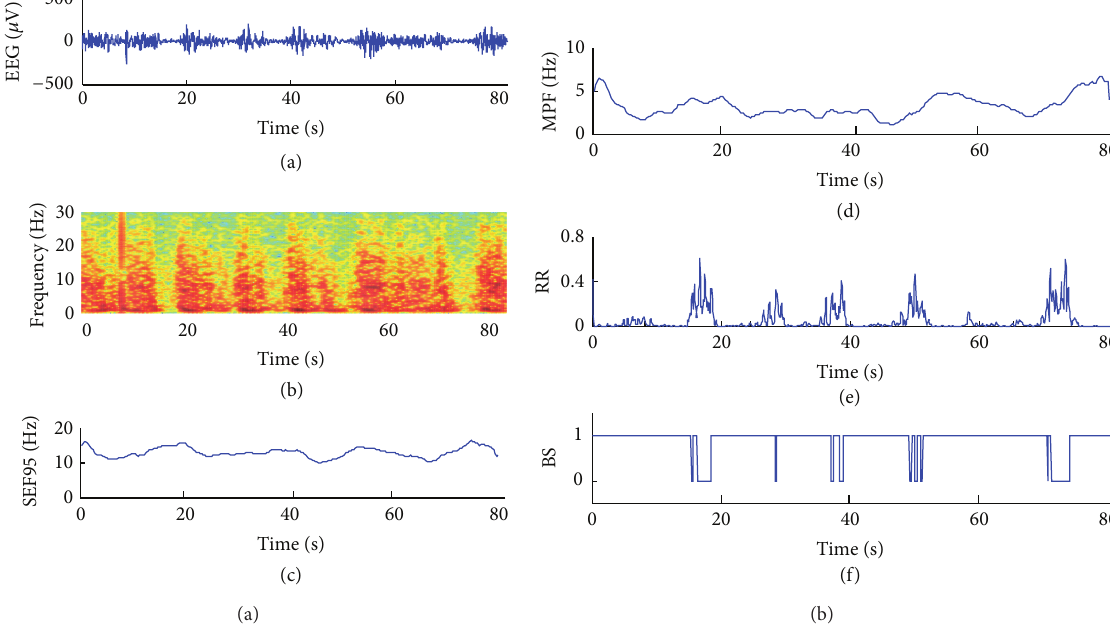
Figure 6: Comparison between the RR method and the spectral analysis based methods for the BSPs detection. (a) A burst suppression interval EEG signal of 80s, (b) frequency spectrum, (c) spectral edge frequency 95 parameter, (d) median electroencephalogram frequency parameter, (e) the RR index, and (f) the BS index of RR.